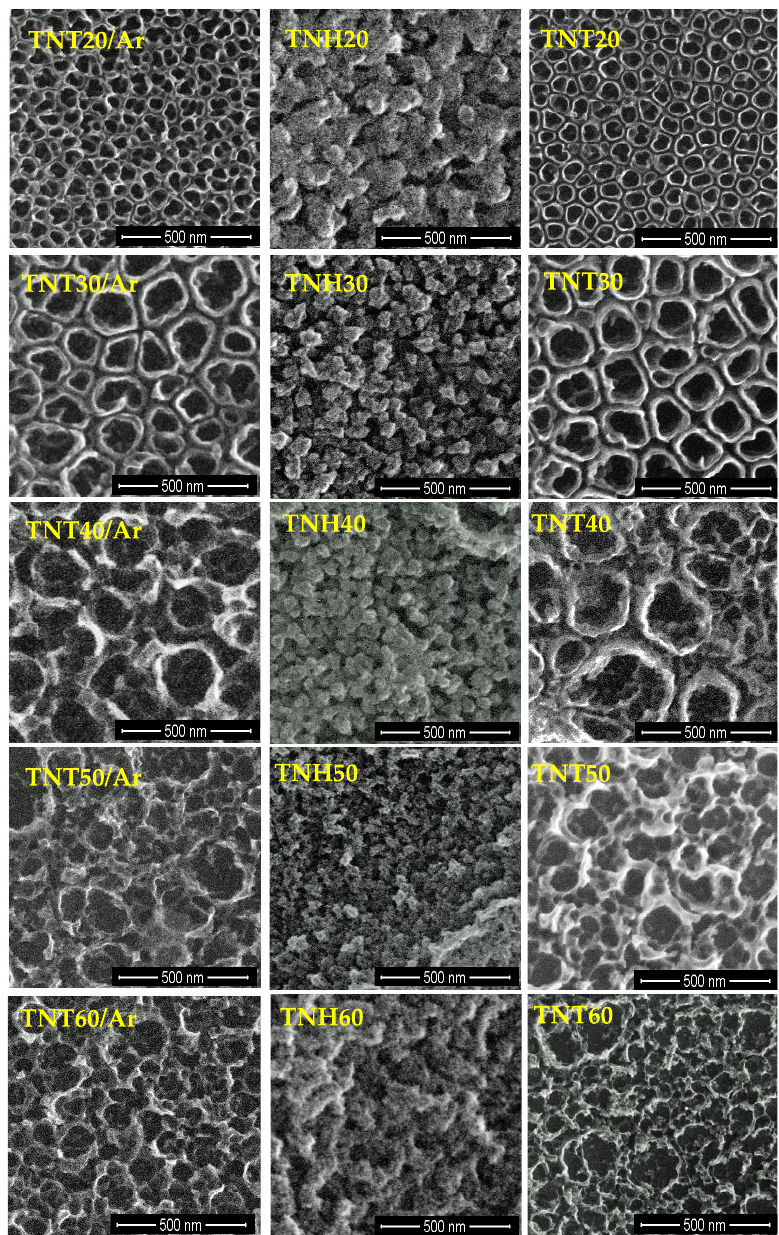
Figure 2. SEM images of Ti6Al4V/TNT20-60/Ar, Ti6Al4V/TNH20-TNH60, and Ti6Al4V/TNT20-60 samples surface.